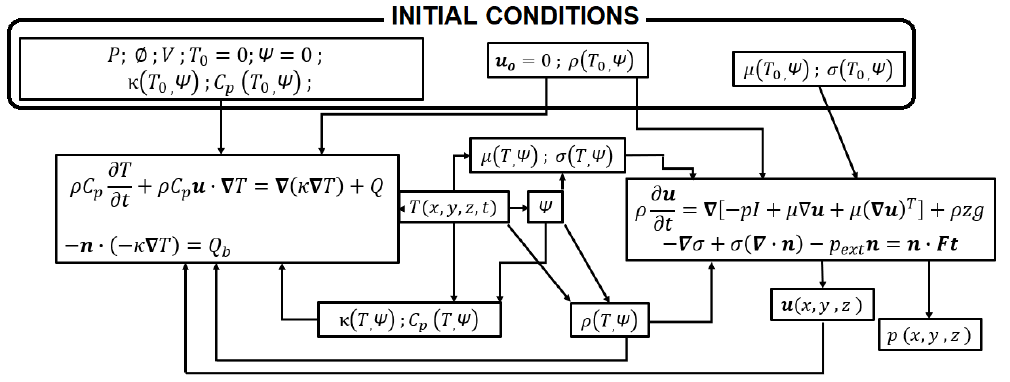
Figure 3. Flux diagram of the constitutive equations, boundary conditions and initial conditions of the thermo-fluidic coupling.